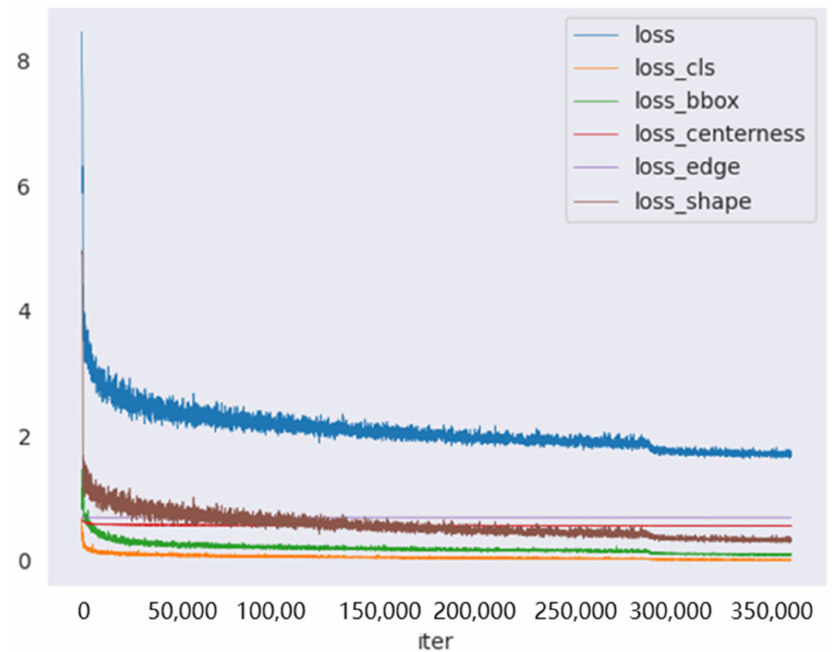
Figure 10. The learning curve for the relationship between the different losses and